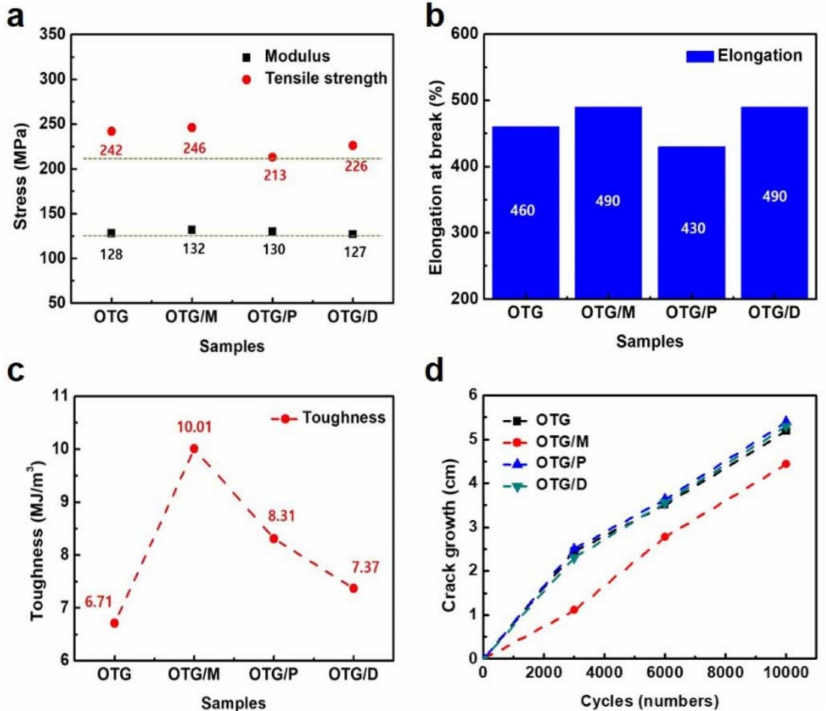
Figure 3. Mechanical properties of elastomer composites. ( a ) Elastic modulus and tensile strength of the elastomer composites with hybrid oils. ( b ) Elongation of the elastomer composites with hybrid oils. ( c ) Toughness of the elastomer composites with hybrid oils. ( d ) Fatigue properties (fatigue crack growth) of the elastomer composites with hybrid